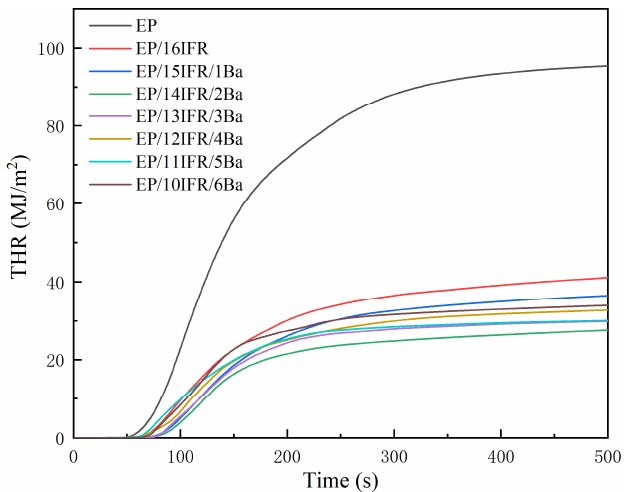
Figure 5. Curves of THR of pure EP and EP composites with time.